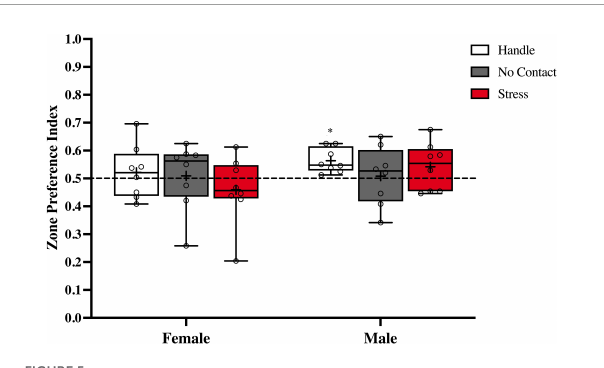
FIGURE5 Zone preference index during the social recognition memory test. Preference indexes comparing time spent in zones with novel vs. familiar conspecifics during the social memory test (M ± Minimum and Maximum). There was no overall preference for the zone that contained the novel or familiar conspecific. ∗ p < 0.01 Handle group versus